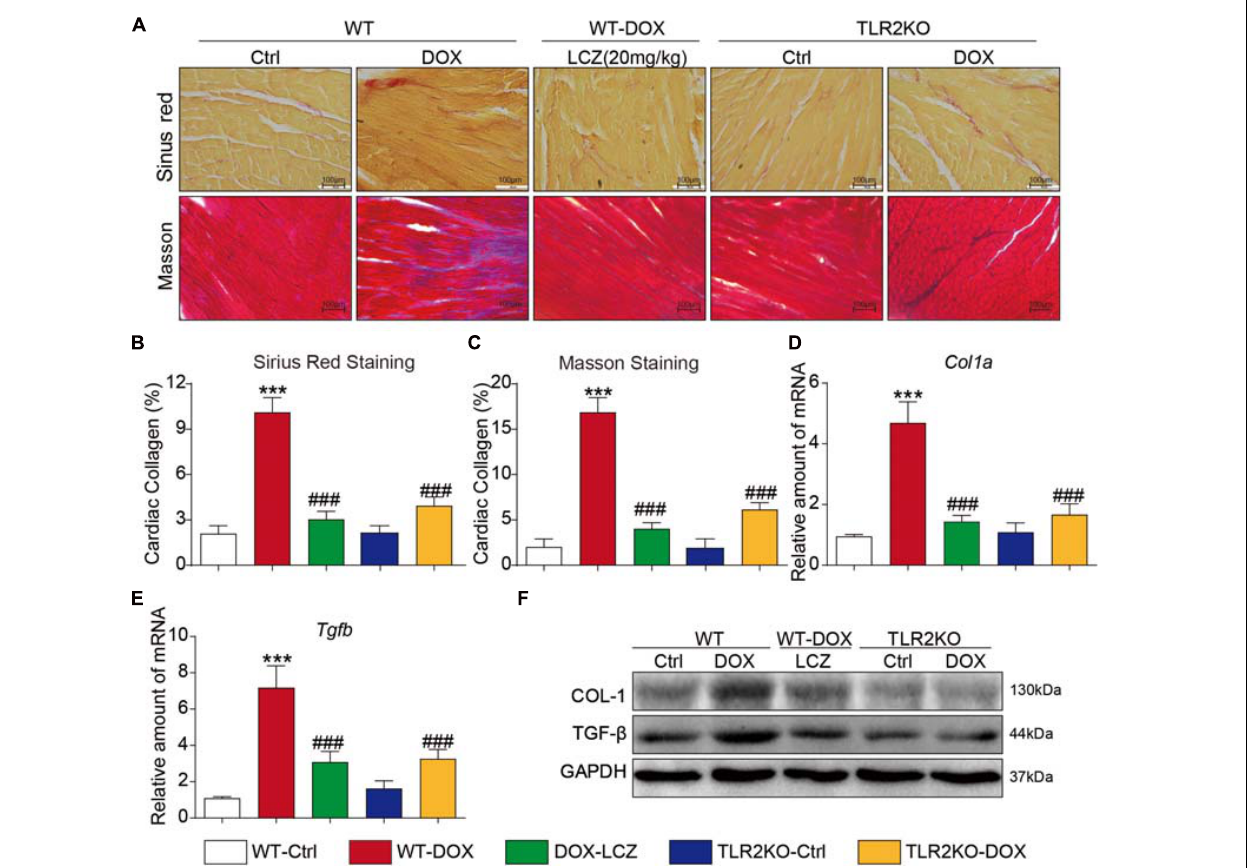
These results paralleled the protein levels of collagen I (COL- I) and TGF- β in the hearts of each group ( Figure 2F and Supplementary Figures 1A,B